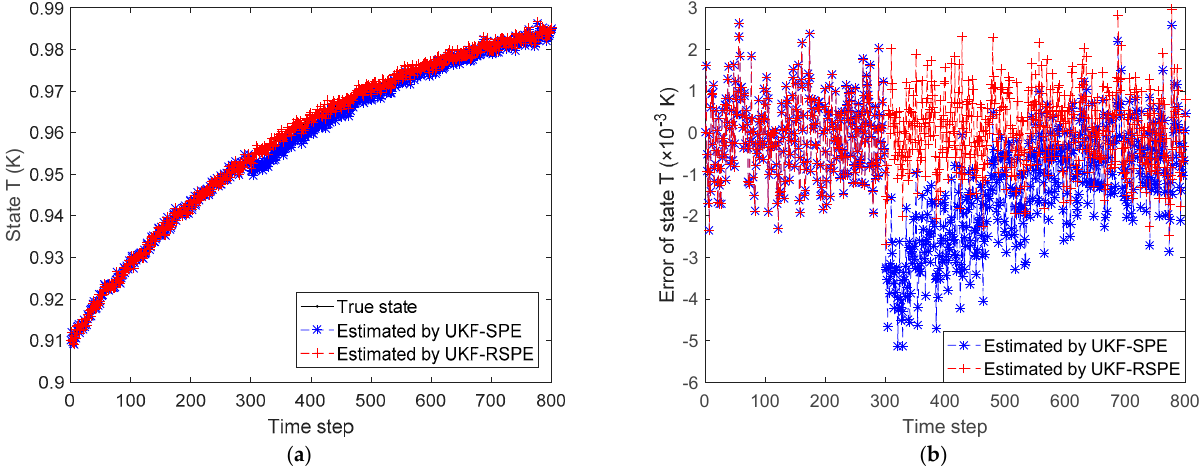
T  in Case Study 2.1: ( a ) estimated k